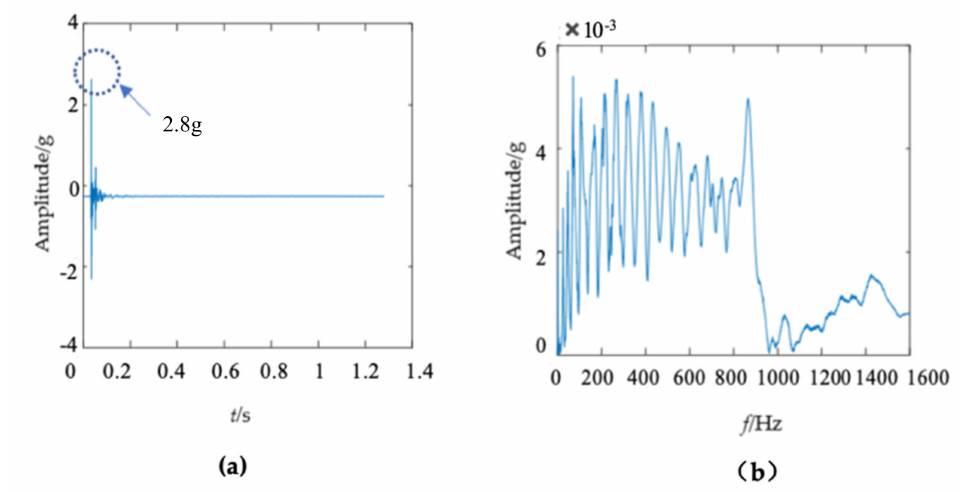
Figure 6. ( a ) Vibration response signal of the wooden utility pole labeled as 57704 in the time domain and ( b ) its corresponding frequency